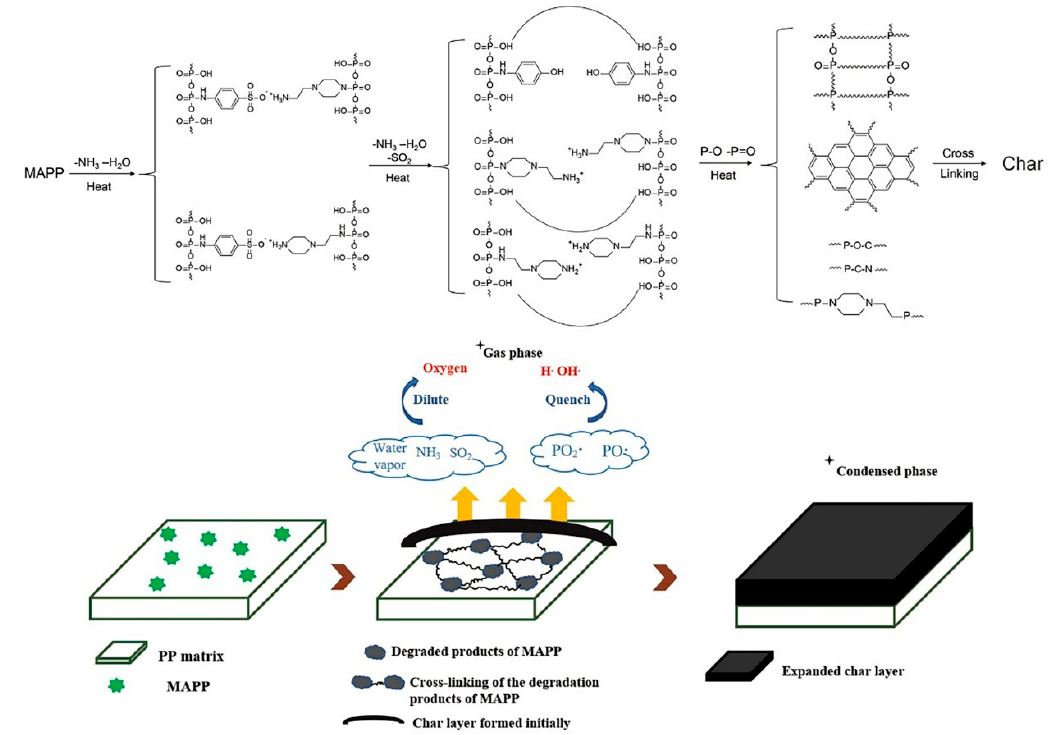
Figure 12. Schematic diagram of the flame-retardant mechanism.